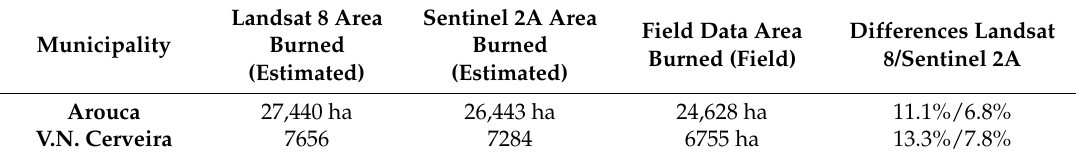
Table 7. Area burned in Arouca and V.N Cerveira based in the methodology proposed in this work and available field